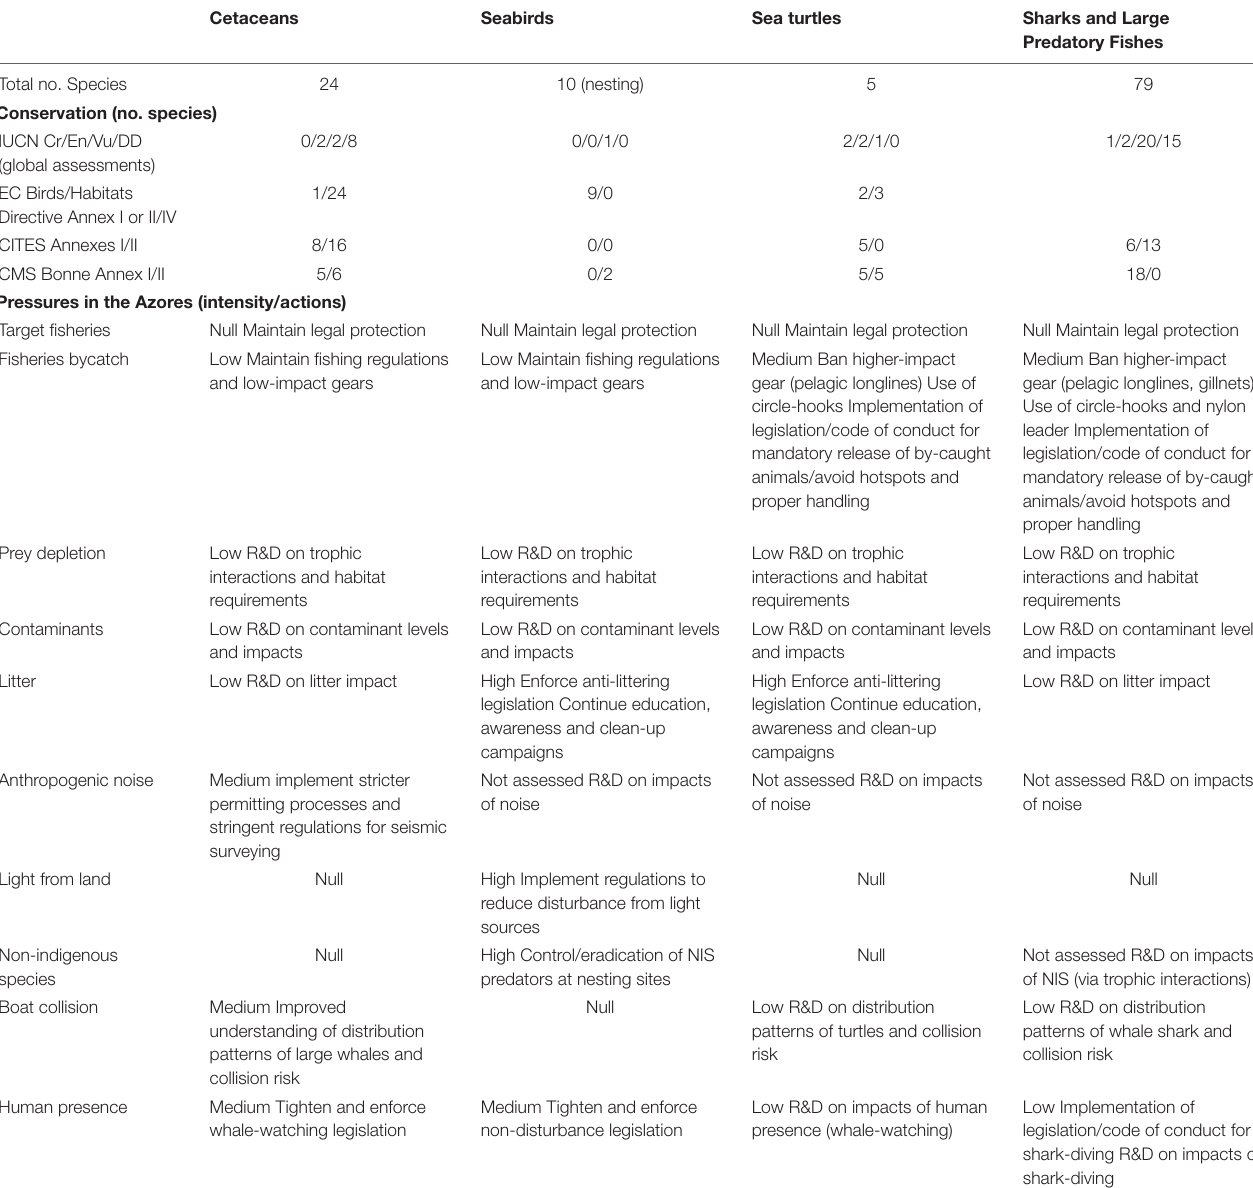
TABLE 1 | Resume of the conservation status, pressures and proposed actions for each of the four groups of marine megafauna occurring in the Azores. Cetaceans Seabirds Sea turtles Sharks and Large